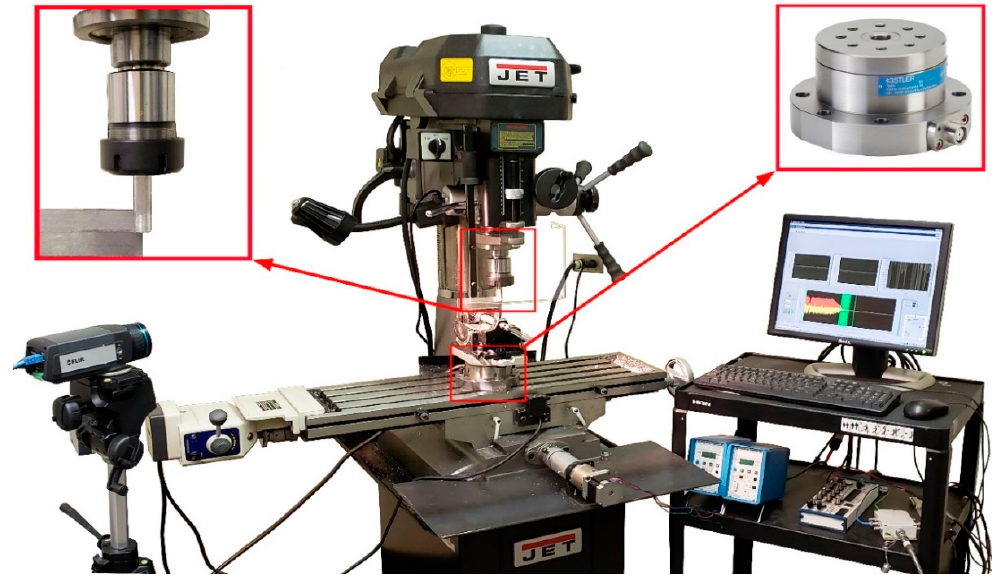
Figure 2. The experimental setup in this study including benchtop milling machine, dynamometer, and data acquisition apparatus.